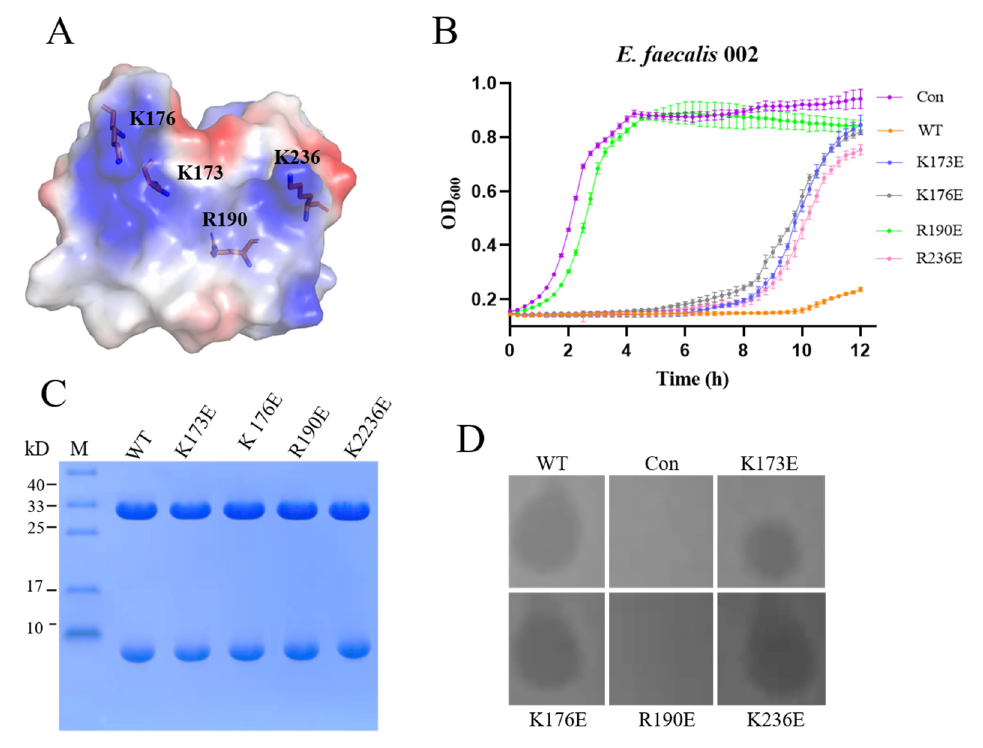
Figure 4. The binding sites of EFm1 for cell wall. ( A ) Residues with a positive charge in the convex region of the monomer; ( B ) Growth curves of the mutants K173E, K176E, R190E and K236E; the mean ± s.e.m is shown; ( C ) SDS-PAGE results of the mutants K173E, K176E, R190E and K236E; ( D ) Plate lysis assay results of the mutants K173E, K176E, R190E and K236E.